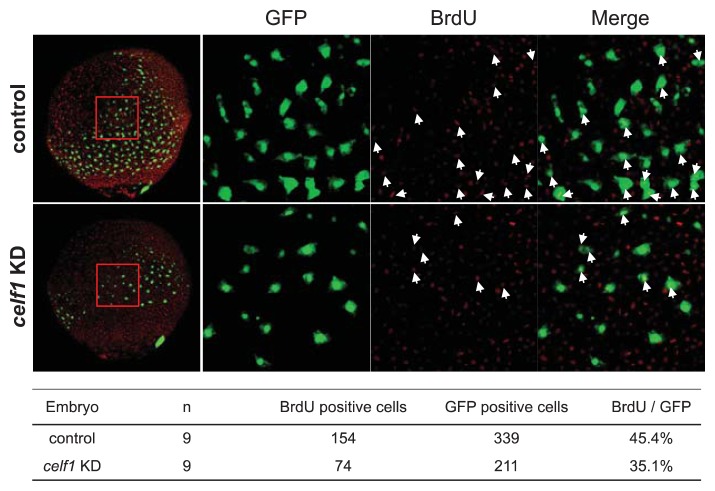
Cell proliferation in zebrafish embryos during gastrulation. BrdU staining was performed in Tg [sox17:GFP] embryos at 9 hpf. Green and red signals indicated GFP-expressing endoderm cells and BrdU positive cells, respectively. Right panels were higher magnification images highlighting endoderm cells with the embryo (left panel). The number of BrdU positive endoderm cells (arrows, double positive cells) significantly decreased in celf1 KD embryos (*p < 0.05).